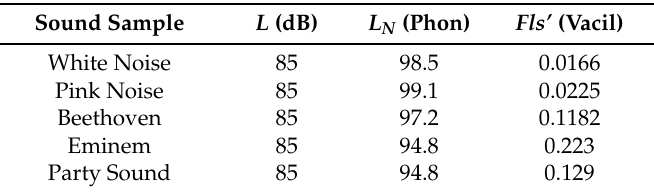
Table 2. Psychoacoustic factors of the unprocessed signals: sound pressure level ( L ), loudness level ( L N ), and specific fluctuation strength ( Fl s’) 1